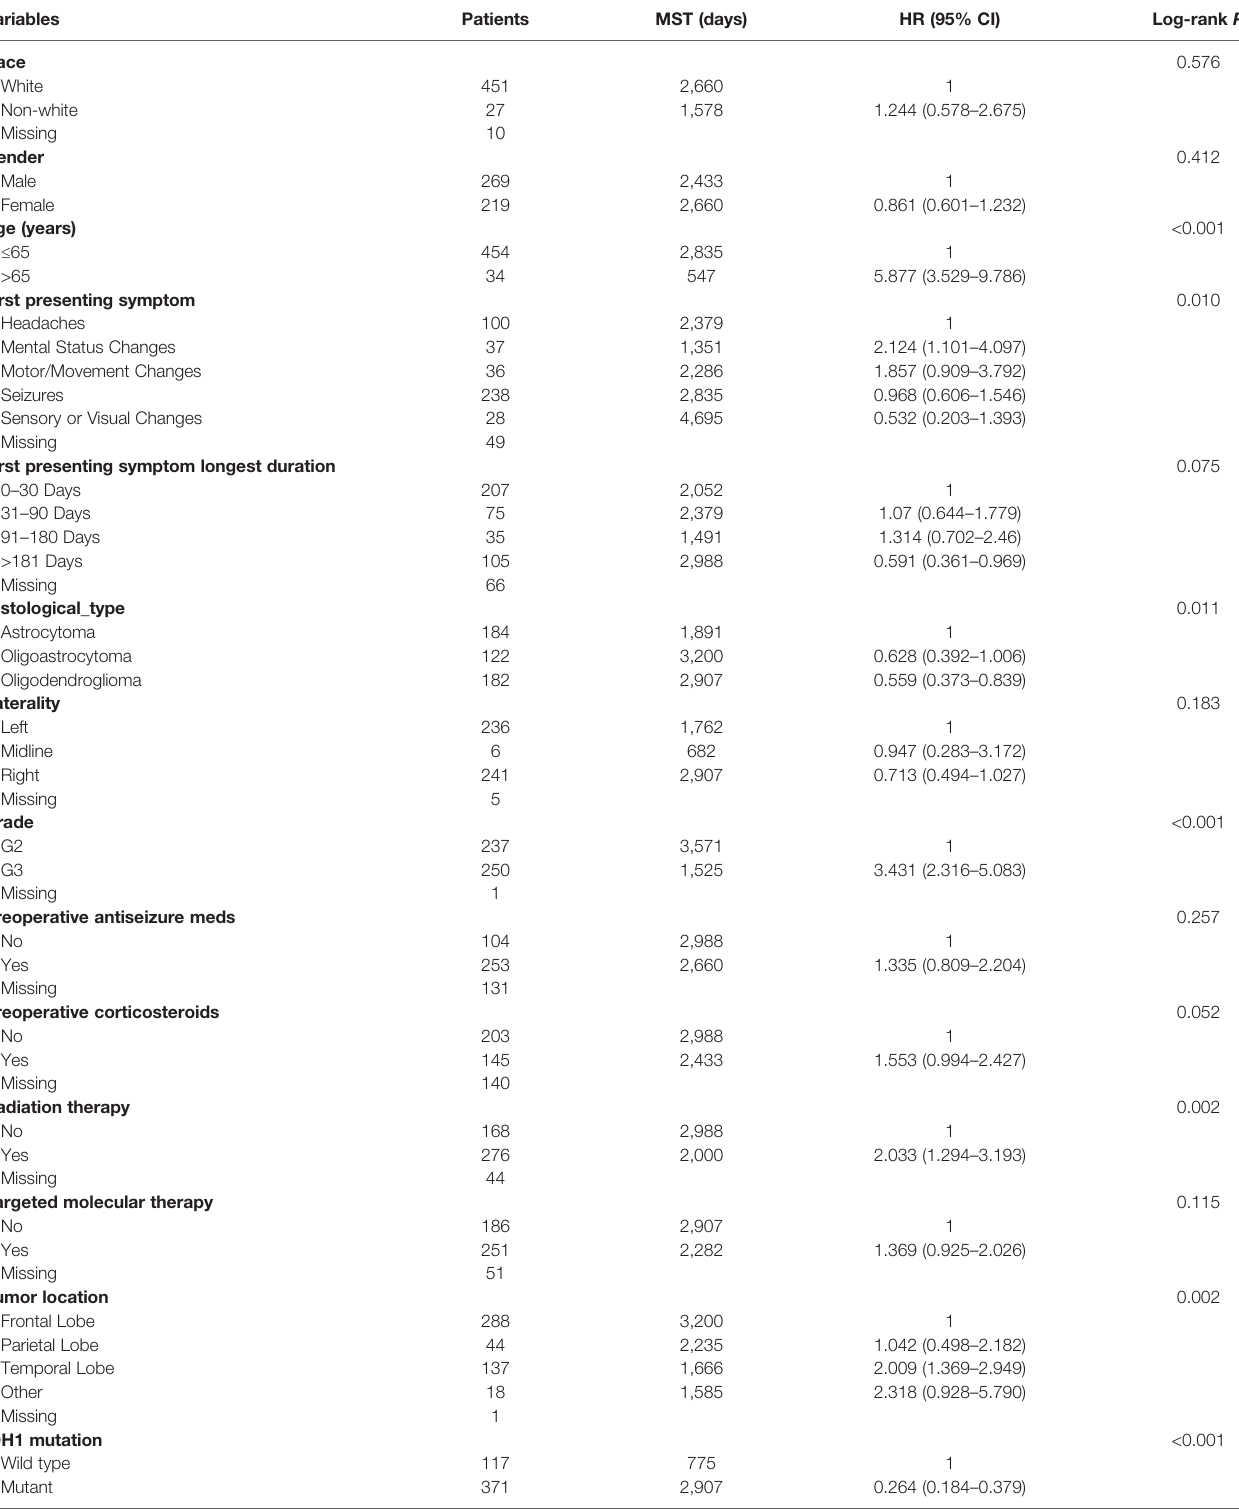
TABLE 1 | Univariate survival analysis of clinical parameter in TCGA LGG